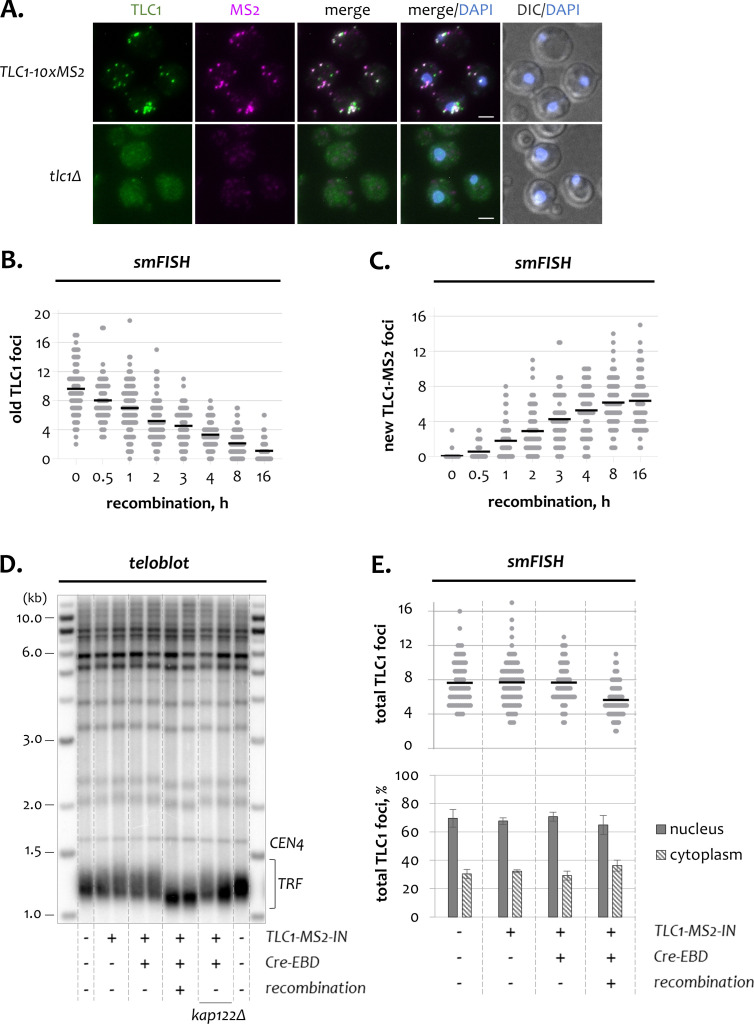
Additional characteristics of the TLC1-[MS2-IN] system.(A) Two-color smFISH analysis of a recombined strain expressing TLC1-10xMS2 and a tlc1Δ negative control strain. TLC1-Cy3 and MS2-Cy5 probes were used. Scale bar, 2 μm. (B, C) The number of old (B) and new (C) TLC1 foci observed by smFISH in individual wild type cells after recombination induction. Horizontal black lines indicate average number of foci. 50–100 cells from three independent experiments were scored. (D) Telomere length analysis in strains with or without the TLC1-[MS2-IN] system. TRF – terminal restriction fragment, CEN4 – migration control. DNA marker sizes are indicated on the left (kb). (E) Total number of TLC1 foci (top) and relative nuclear and cytoplasmic TLC1 fractions (bottom) detected by smFISH in strains with or without TLC1-[MS2-IN]. Horizontal black lines (top) indicate average number of foci. 50–100 cells from three independent experiments were scored.Figure 2—figure supplement 1—source data 1.Numerical data used to generate Figure 2—figure supplement 1.